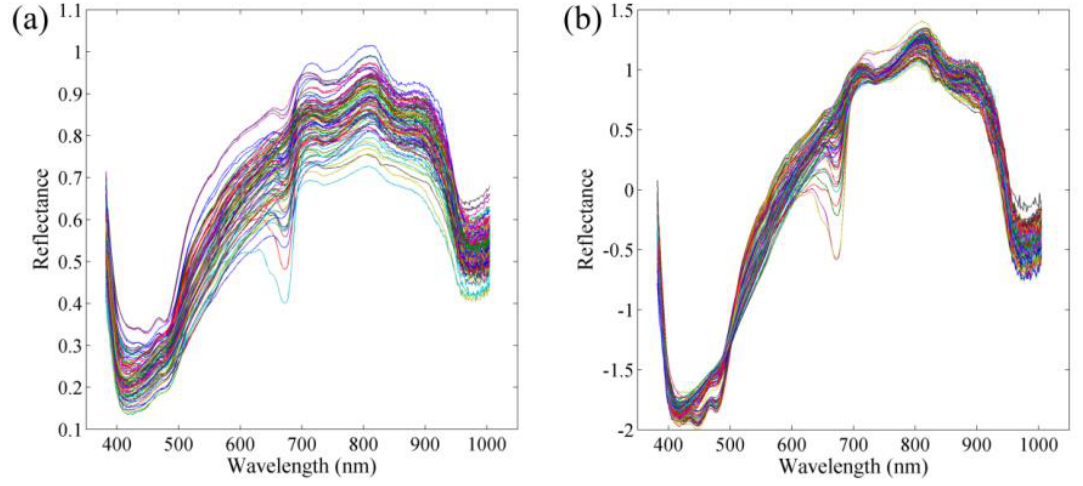
Figure 1. ( a ) Raw; ( b ) SNV preprocessed spectral curves of all potato samples. To extract textural data from hyperspectral images, the high-dimensional data blocks were transformed using PCA for dimensionality reduction, the first three PC images (PC1, PC2, and PC3 images) were used for textural data extraction, as displayed in Figure 2. For